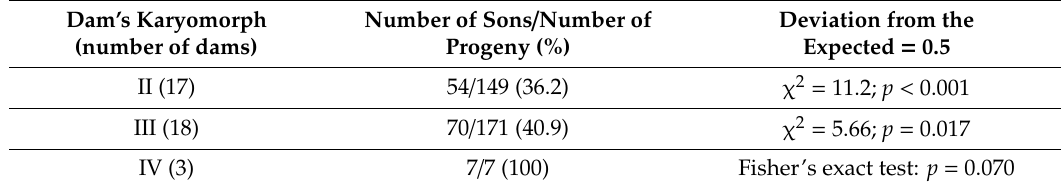
Table 1. Comparison of sex ratio in the progeny born to the female carriers of di ff erent karyomorphs Dam’s